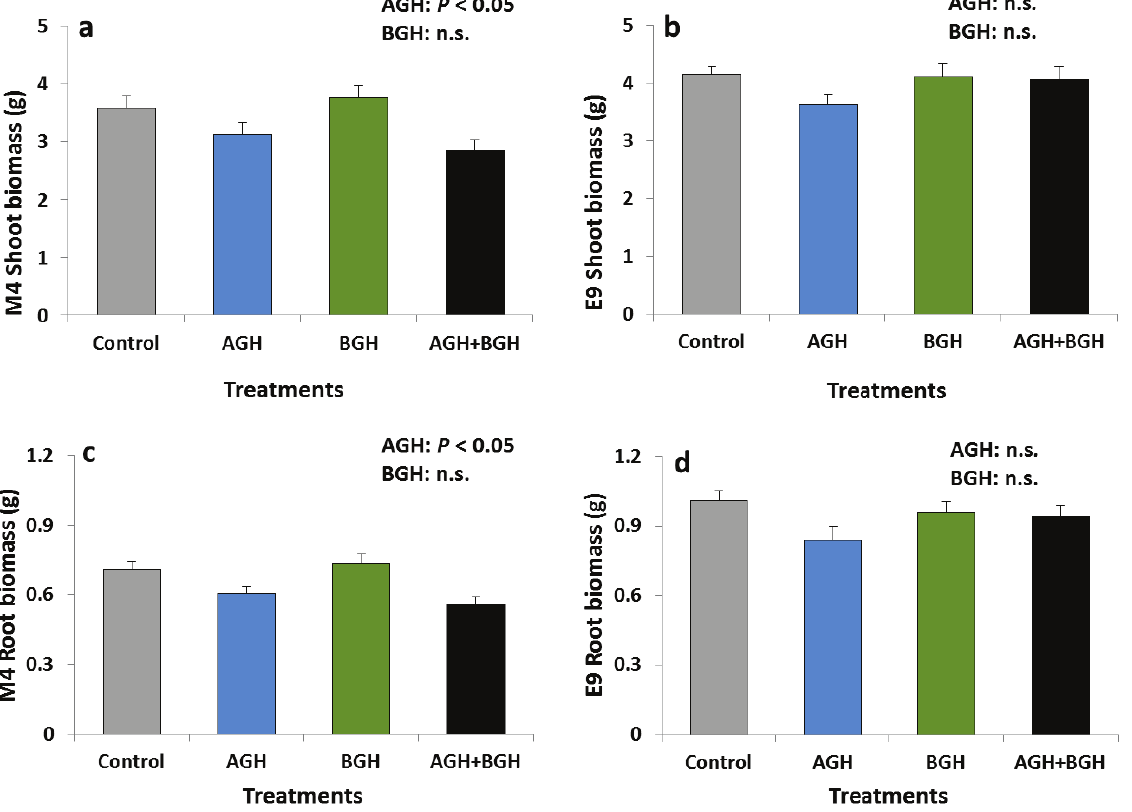
Figure 2. Shoot biomass (g) of the genotype M4 (a) and E9 (b) and root biomass (g) of the genotype M4 (c) and E9 (d) ( mean ± SE). Treatments: Control, AGH: aboveground herbivory only, BGH: belowground herbivory only, AGH+BGH: aboveground herbivory followed by belowground herbivory with a lag phase of seven